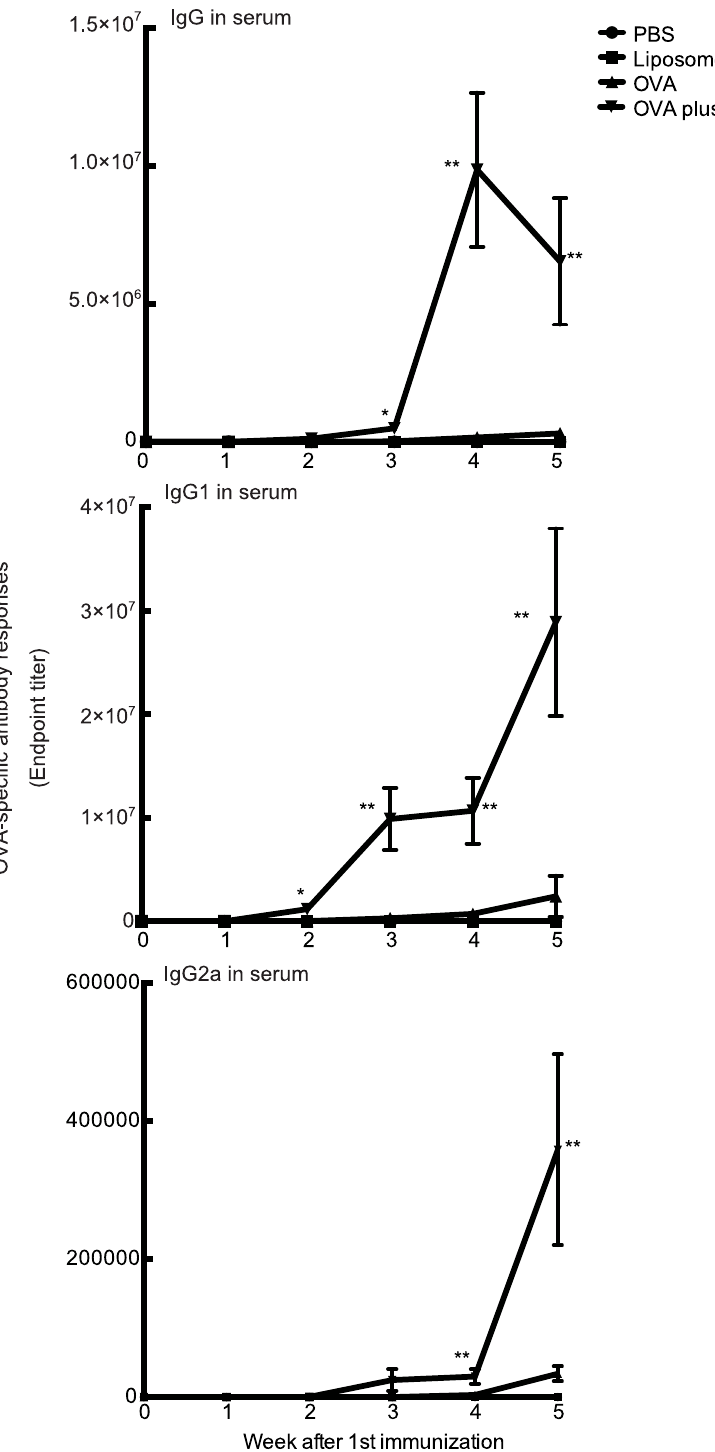
Fig 3. Kinetics of the appearance of OVA-specific serum IgG in BALB/c female mice immunized intranasally with OVA and DOTAP/DC-chol liposomes. BALB/c female mice were immunized intranasally with PBS alone, DOTAP/DC-chol liposomes (0.4 μ mol/mouse) alone, OVA (5 μ g/mouse) alone, or OVA (5 μ g/mouse) plus DOTAP/DC-chol liposomes (0.4 μ mol/mouse) once weekly (days 0, 7, 14, 21, and 28). Serum was collected every week immediately prior to immunization (days 0, 7, 14, 21, 28, and 35).